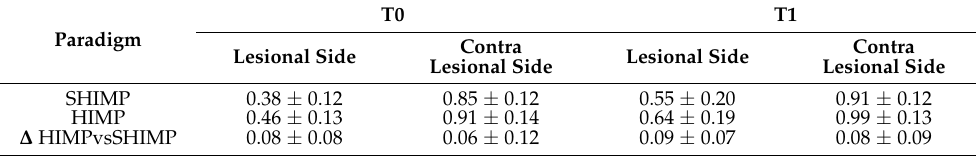
Figure 3. Objective measures of horizontal semicircular canal function at the time at the chronic stage (50 days later than the onset of the acute vestibular syndrome) in both paradigm HIMPs ( A , B ) and SHIMPs ( C , D ) with video Head Impulse test Technology for one patient with acute unilateral (right) superior vestibular neuritis. Each panel shows a superimposed time series of head velocity (black for the head impulses) and the corresponding eye velocity (red) for the lateral canal dynamic function. The signs of head velocity for leftward impulses and of eye velocity for rightward impulses have been inverted to allow for easier comparison. Normal horizontal Vestibulo Ocular Reflex (VOR) gains are approximately 0.7–1.0 [4]. Chronic stage ( A , B ) HIMP paradigm. For rotations to the affected side, slow phase eye velocity is back within the limits of the norm, VOR gain is 1.04, then for head turns to the healthy side, VOR gain is 1.06. There is still a shower of tiny compensatory (Covert + Overt) saccades during and at the end of the head turn (black arrow). When the head is turned to the left contralesional side, anti-compensatory saccades (AcS) eye movements in the direction of the head movement have disappeared (see Figure 1, panel A, for comparison). Chronic stage ( C , D ) SHIMP paradigm. In this paradigm for rotations toward the affected side, slow phase of the eye velocity is back within the limits of the norm (red traces vs black traces). Note how during the head turn, the eye slow phase velocity of the VOR is within the limits of the norm in comparison with the same value in the HIMP paradigm [VOR gain is 0.97]. For head turns to the healthy side, VOR gain is exactly the same, 1.01. The blue arrows indicate the return to normal angular velocity of the slow phase of the VOR when the head, in both paradigms, is turned toward the affected side. When the head is turned to the left contralesional, healthy side, anti-compensatory overt SHIMPs saccades at the end of the head turn (black arrow, C ) eye movements in the direction of the head movement can be observed. In sharp contrast with the acute stage, on this occasion, when the head is turned toward the right affected side, note how anti-compensatory SHIMPs saccades have reappeared. Table 2. Descriptive statistics of Vestibulo Ocular Reflex gain values across